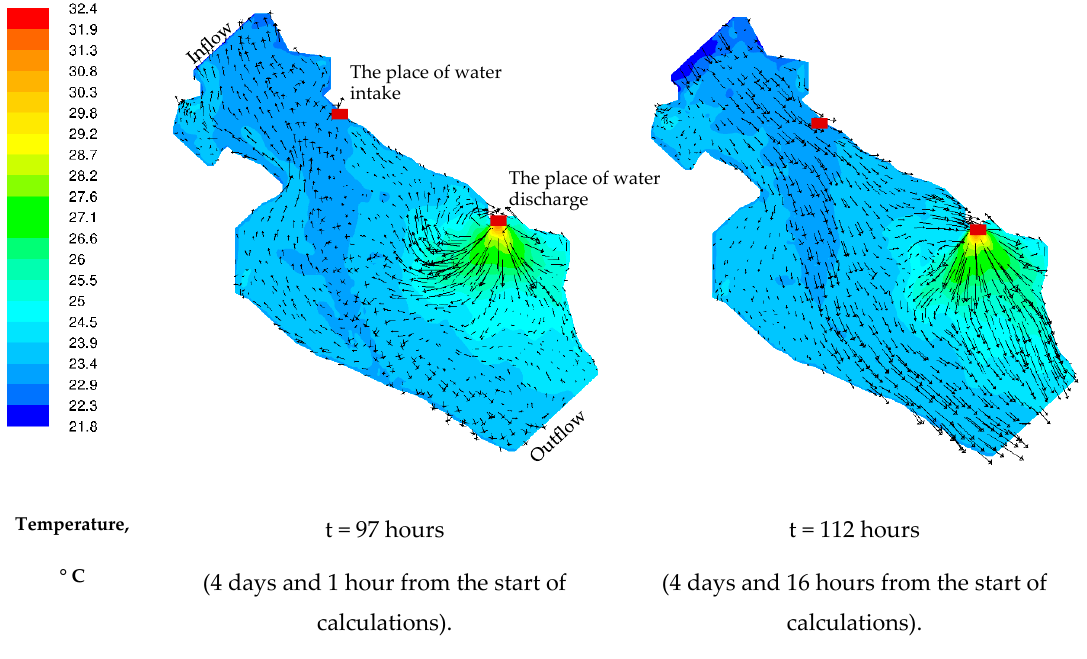
Figure 11. Temperature fields in the near-surface layer for calm conditions; the time from the start of calculations (t). The calculations were carried out for the period starting from midnight.